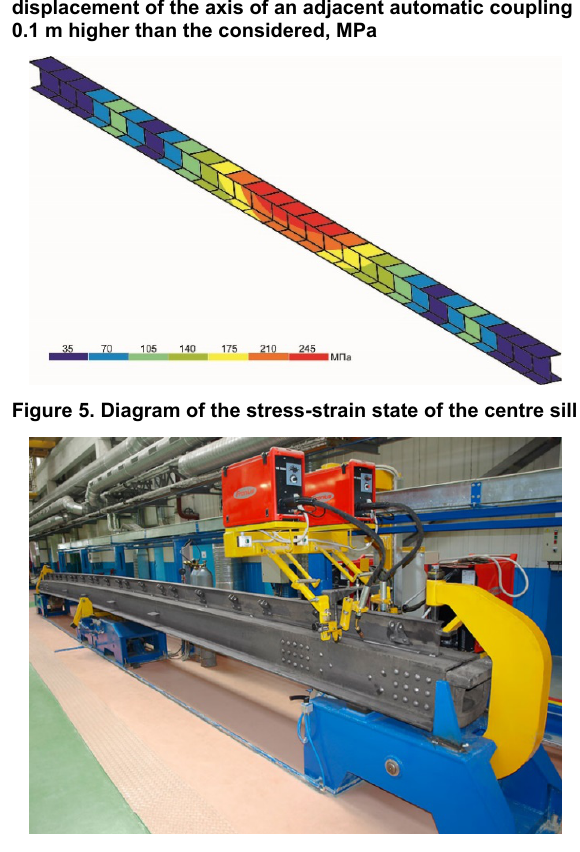
Figure 6. Robotic complex for manufacturing of the centre sill